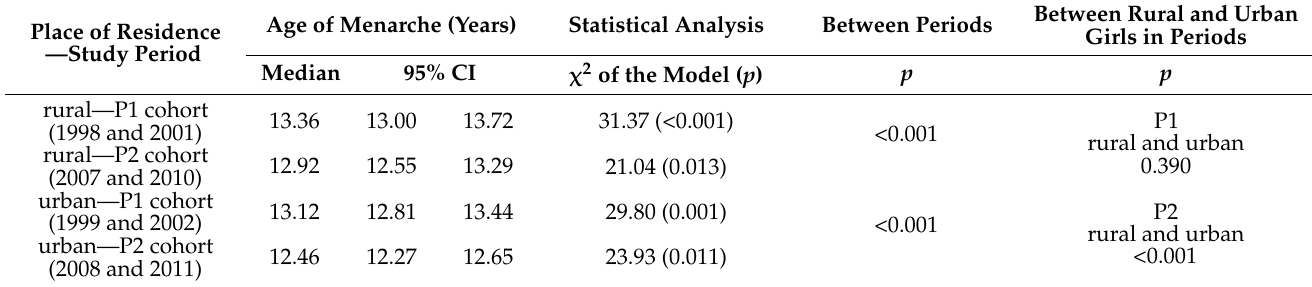
Table 3. Medians with 95% confidence intervals, showing χ 2 of the fitted probit models for estimated ages of menarche and p -values between groups(rural and urban, P1 and P2